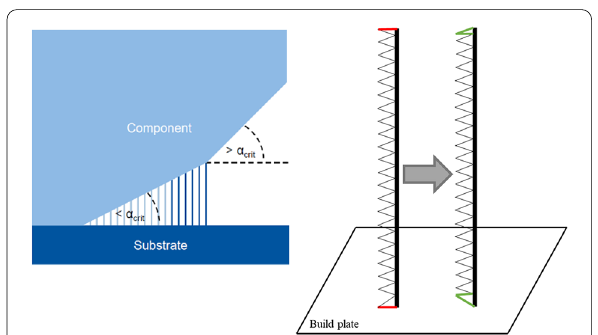
Figure 4 Critical overhang angle (left) and modification of texture at edges (right)